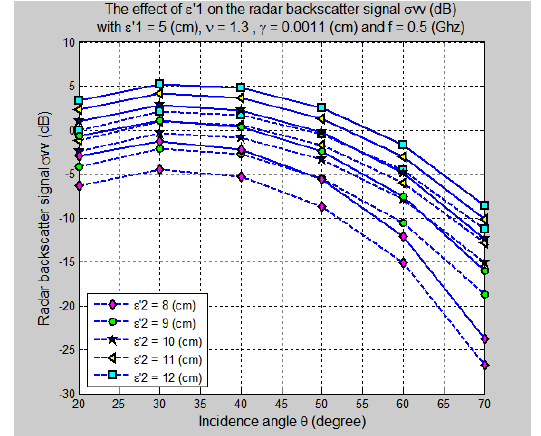
Figure 9: Backscattering coefficient dependence on 𝛆 𝟏′ at HH polarization for bare soil (dashed line) and for vegetated soil (full line)